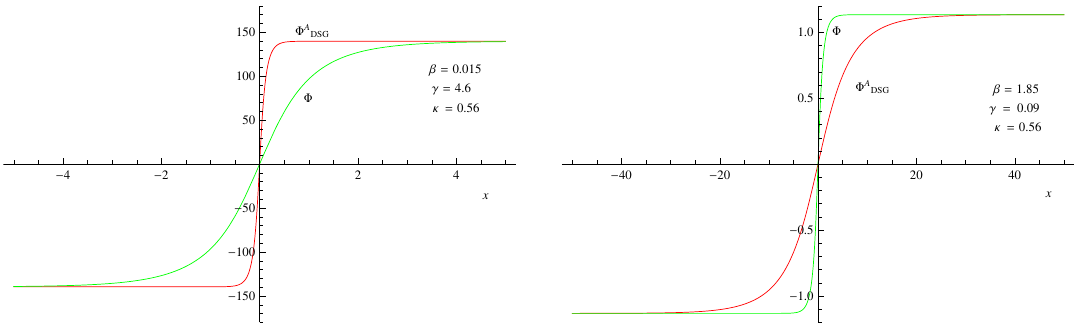
Figure 12 . The kinks Φ (green) and Φ A (red) as a function of x for weak and large coupling DSG parameter β . Left: for β = 0 . 015 , γ = 4 . 6 . Right: for β = 1 . 85 , γ = 0 . 09 . In the both cases θ 0 = 2 π/ 3 , M = 1 , κ = 0 . 56 , ρ 1 = 0 . 41 , ρ 2 = − 0 . 65 , θ 1 = 0 . 138 , θ 2 = 0 . 85 , σ = 1